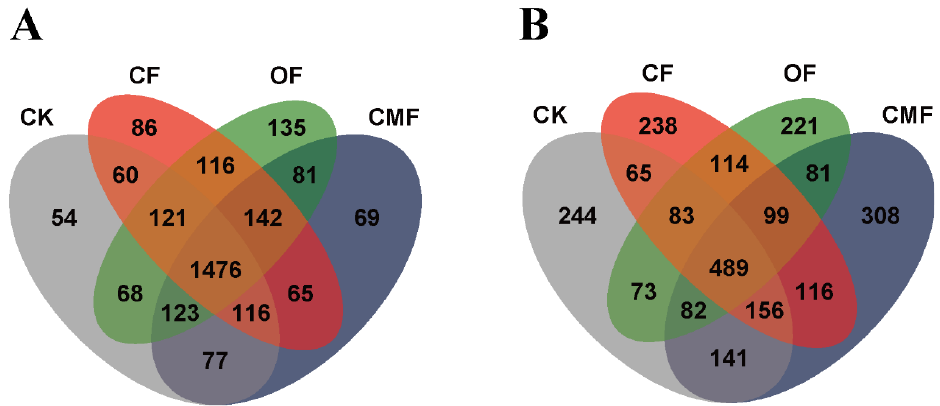
Figure 4. Venn diagram of the number of shared and unique OTUs under the different fertilization treatments in soil bacterial ( A ) and fungal communities ( B ). OTUs are defined at 97% sequence similarity. CK, control; CF, compound fertilizer; OF, organic fertilizer; CMF, compound microbial fertilizer.